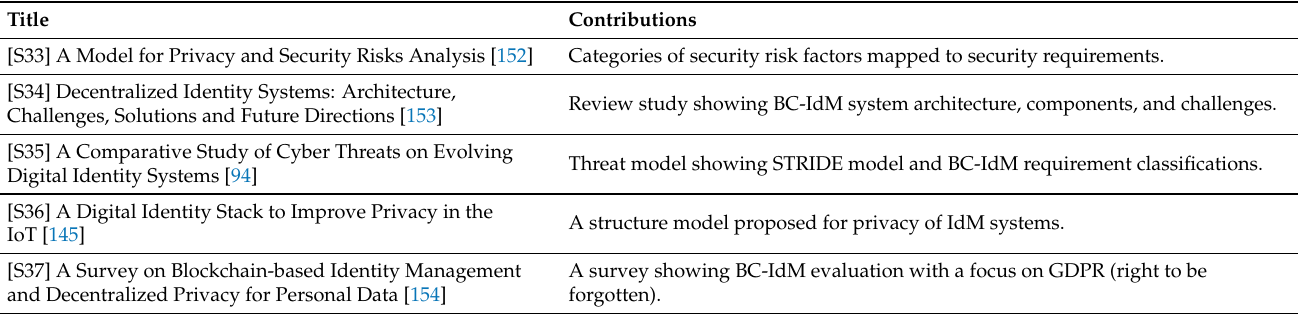
Table A2. Contributions of IdM security risk